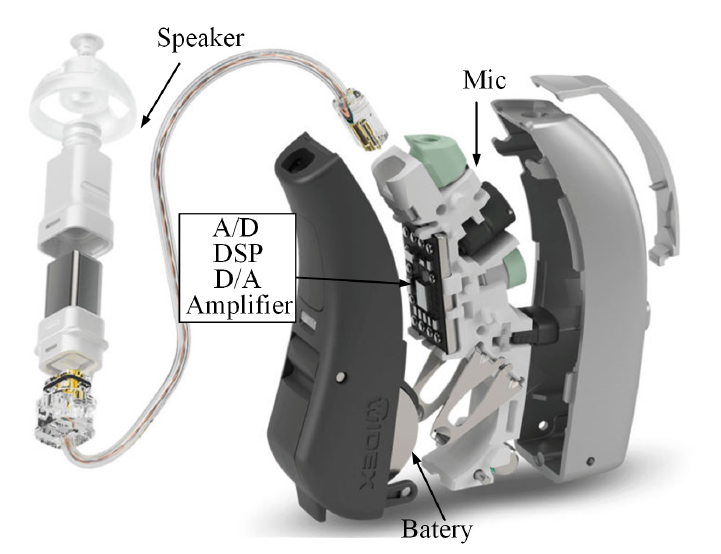
Figure 2. Basic digital hearing aid